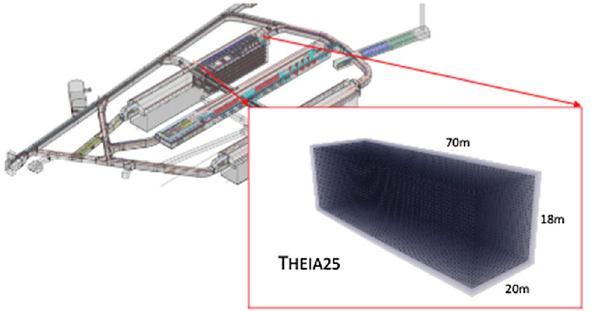
Fig. 1 Asketchof Theia -25siteintheplannedfourthDUNEcavernat SURF and a box-shape detector outline. The maximum space available in terms of fiducial volume is shown